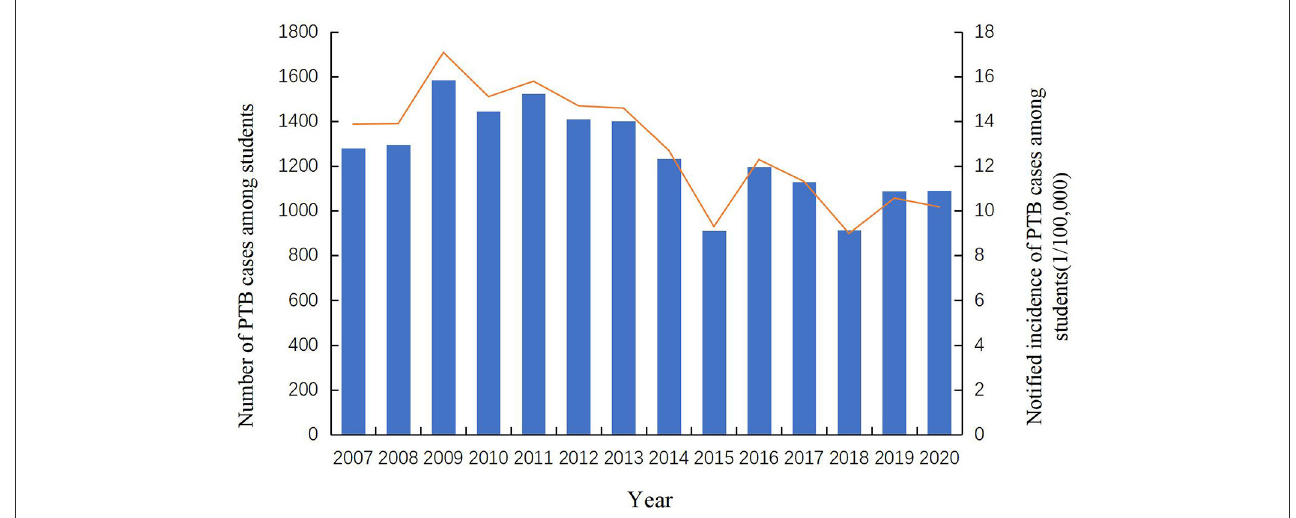
FIGURE1 Trend of notified PTB incidence and notified number of PTB cases by years.